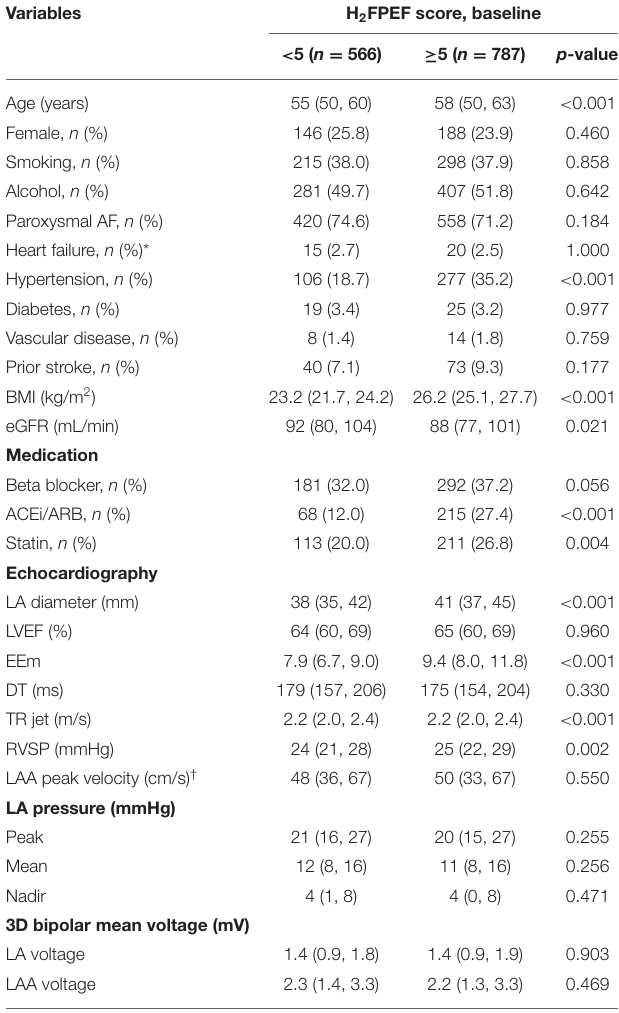
TABLE 2 | Comparison of the baseline characteristics based on H 2 FPEF score 5 in non-gender-related CHA 2 DS 2 -VA score 0 ∼ 1 patients with AF.